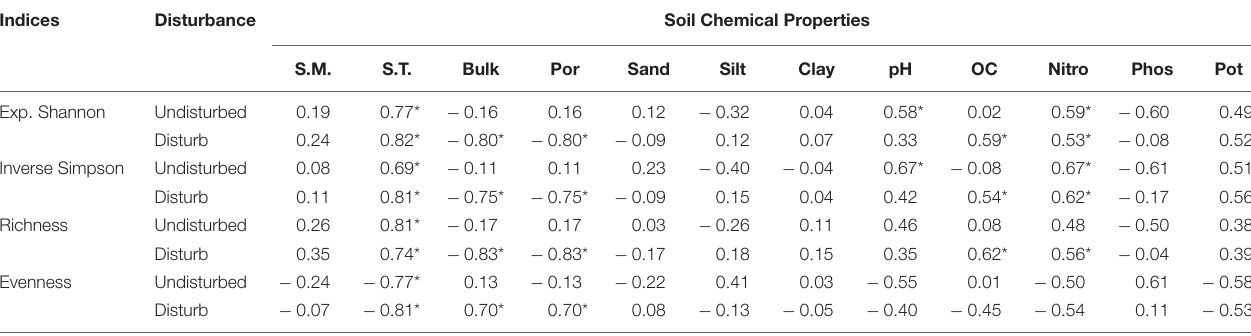
TABLE 2 | Correlation coefficients between phytosociological indices and soil parameters in VoFNP. Indices Disturbance